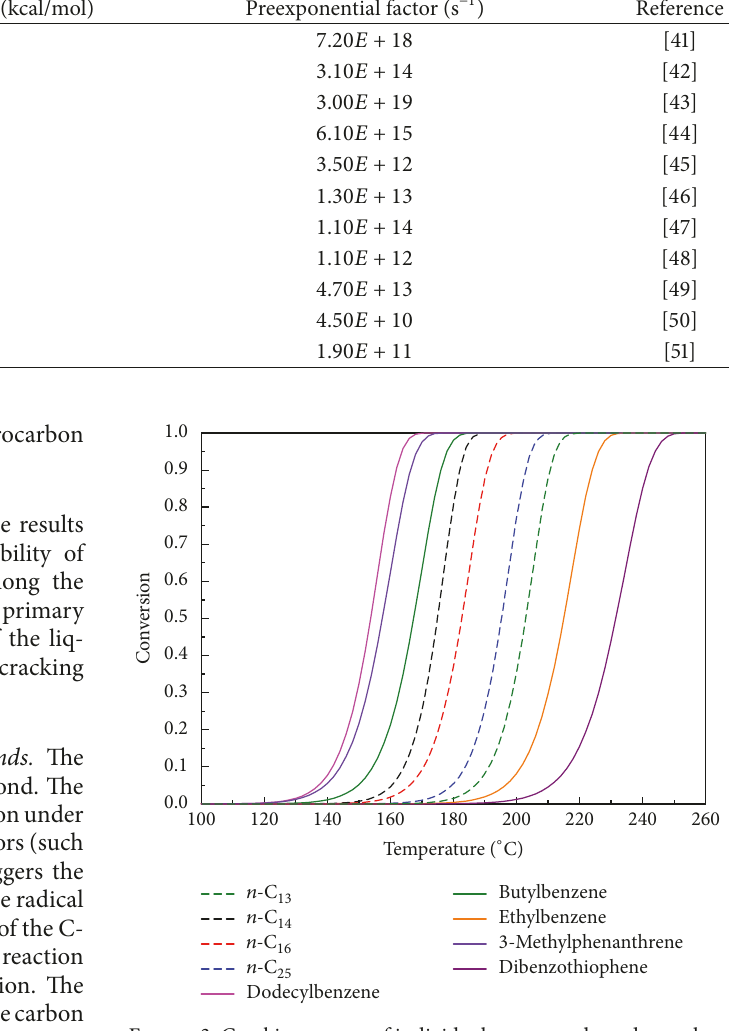
Figure 3: Cracking curves of individual compounds under geolog- ical heating rate (2 ∘